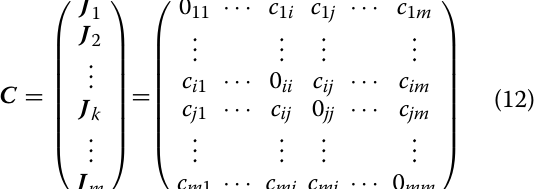
The constrained forms/structures of metamorphic joints should correspond with an equivalent resistance sketch. According to the equivalent resistance matrix described